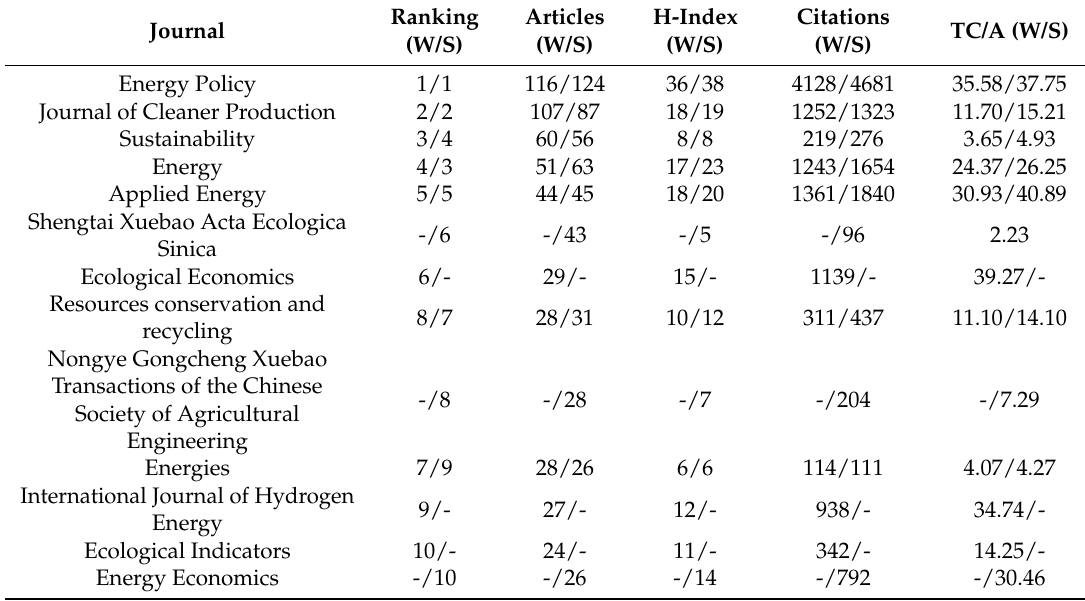
Table 6. Distribution of articles by journal (WoS/Scopus).